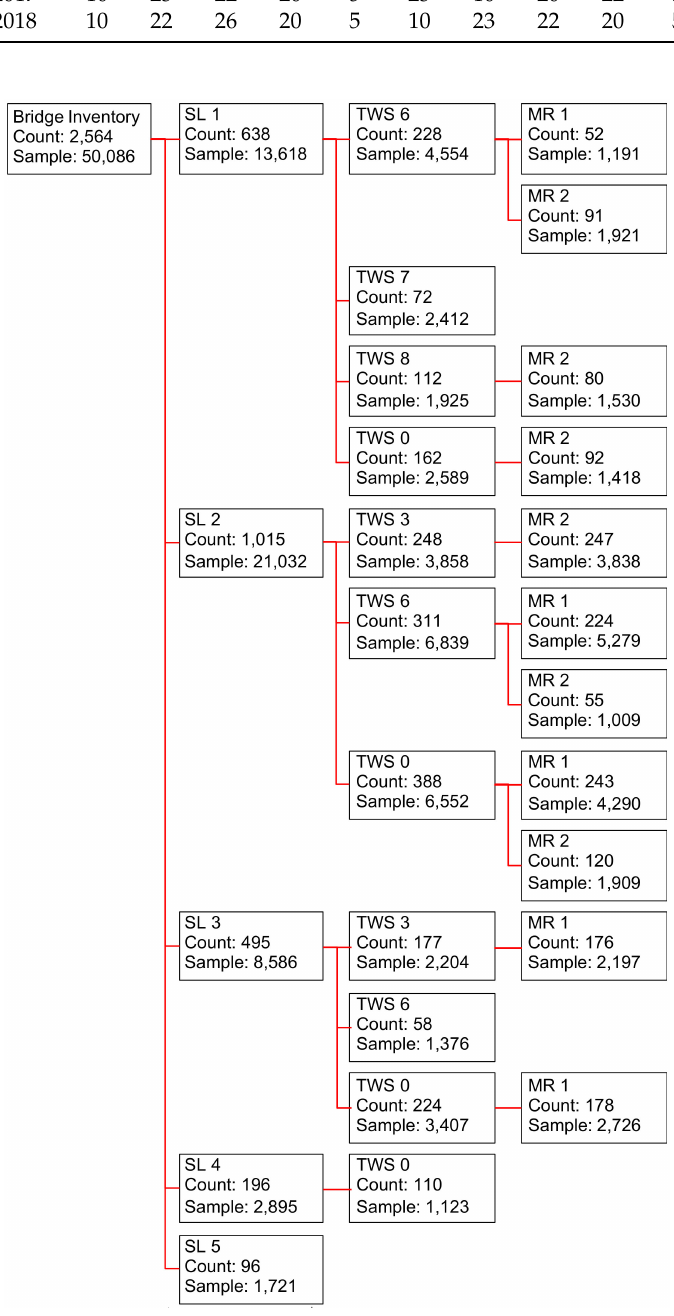
Figure 4. Classification tree for Wyoming bridges using explanatory variables from a single year (2013) of inspection data for deck